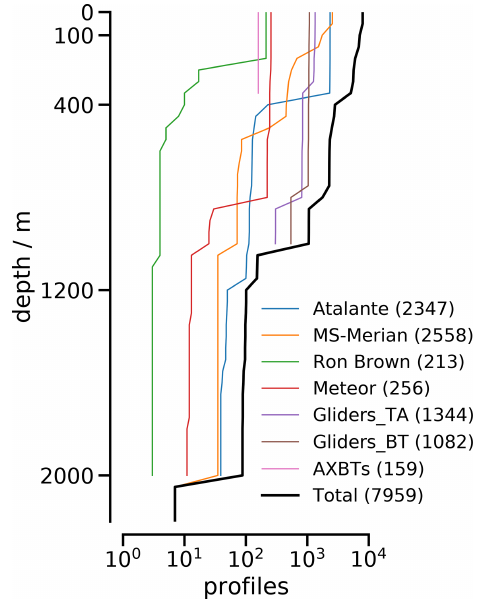
Figure 5. Number of profiles sampling seawater properties at the indicated depth. Ship-based profiling is from CTD casts, underway CTDs, XBTs, and moving vessel profilers. AXBTs were dropped by the P-3.